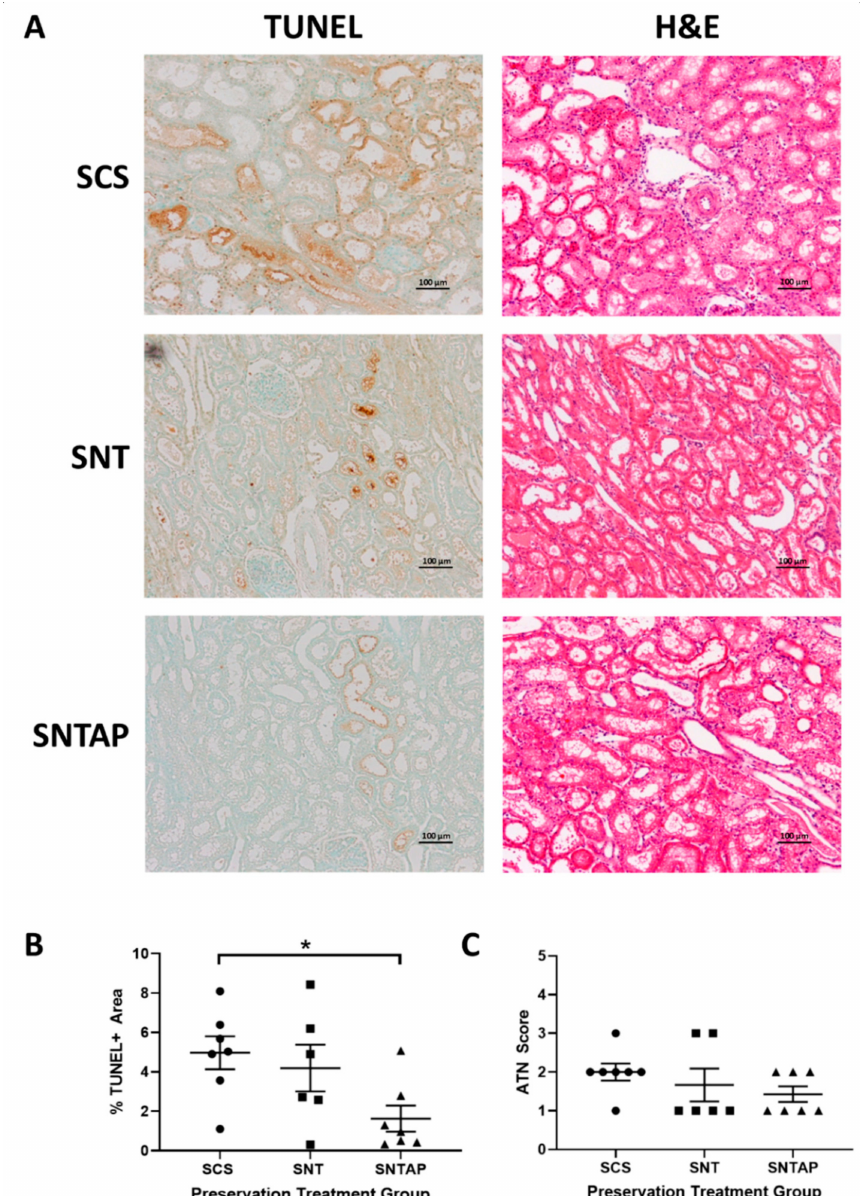
Figure 3. Subnormothermic perfusion with AP39 reduces tissue apoptosis and acute tubular necrosis. ( A ) Representative Terminal deoxynucleotidyl transferase dUTP nick end labeling (TUNEL) and Hematoxylin and Eosin (H&E) images of formalin-fixed DCD kidney sections after 4 h of preservation treatment and 4 h of reperfusion. Images were taken at 10 × magnification (scale bar = 100 µ m). ( B ) Mean %TUNEL+ area, as determined by ImageJ, using a ratio of the TUNEL+ area (brown) to total tubular area. Each individual data point represents the mean %TUNEL+ area of 10 random fields of view of one porcine kidney sample. ( C ) Acute tubular necrosis (ATN) scores based on H&E staining. Each individual data point represents the score assigned to one porcine kidney sample. Lines in ( B , C ) represent the means ± SEM. Values in ( B , C ) were compared using one-way ANOVA followed by Tukey’s post-hoc test. * p < 0.05. Circles represent values for static cold storage (SCS, n = 7). Squares represent values for subnormothermic perfusion (SNT, n = 6). Triangles represent values for subnormothermic perfusion with 200 nM AP39 (SNTAP, n =